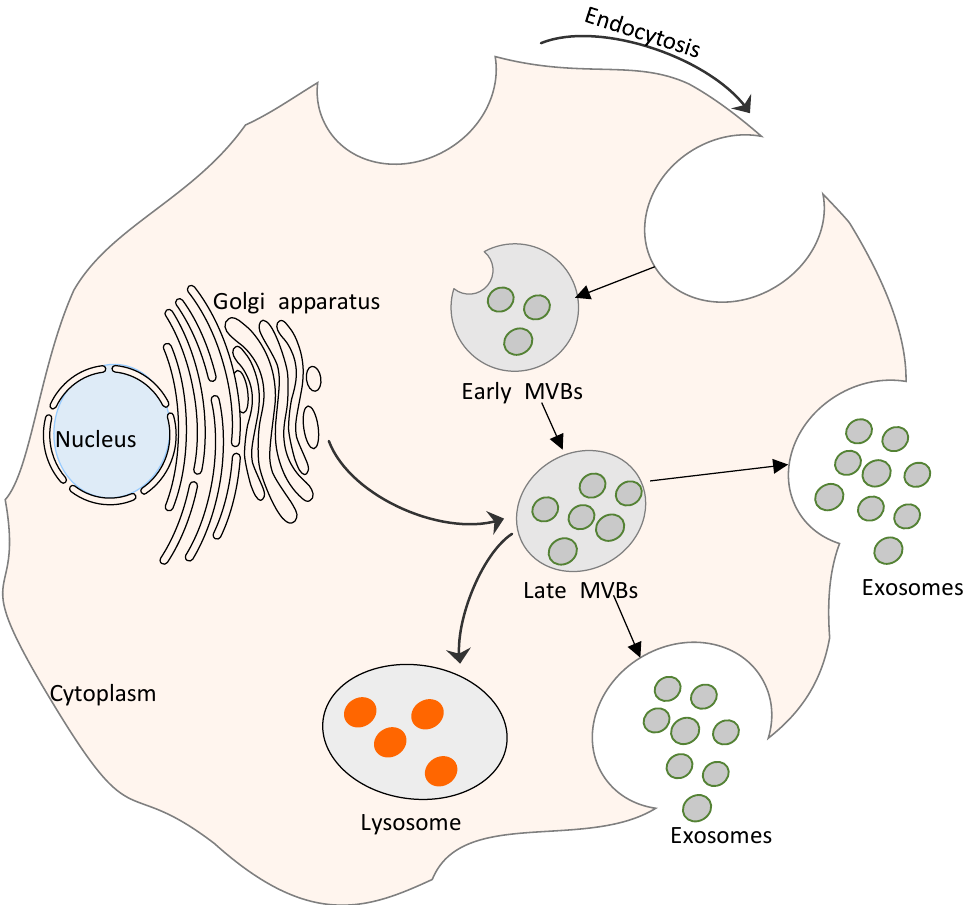
Figure 1. Exosome biogenesis. The process starts with an invagination of the endosomal membrane, and involves Rab GTPase and endosomal sorting complexes required for transport (ESCRTs). The delivery of cargo to recipient cells occurs via ligand – receptor interactions between the exosome and the host cell.